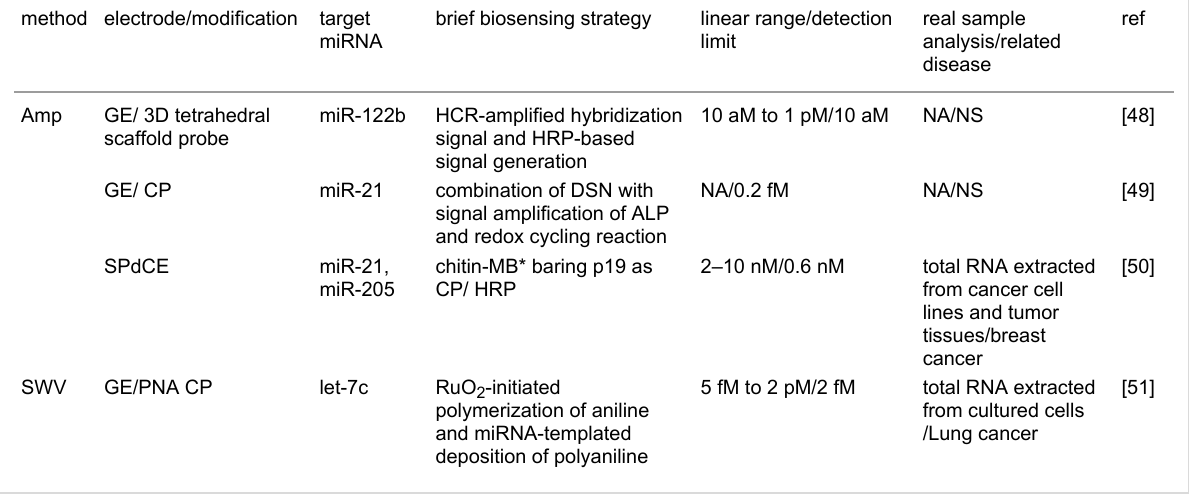
Table 3: The comparison of the proposed electrochemical nanobiosensor specifications with selected recently published electrochemical biosensors for the detection of miRNA. a method electrode/modification target